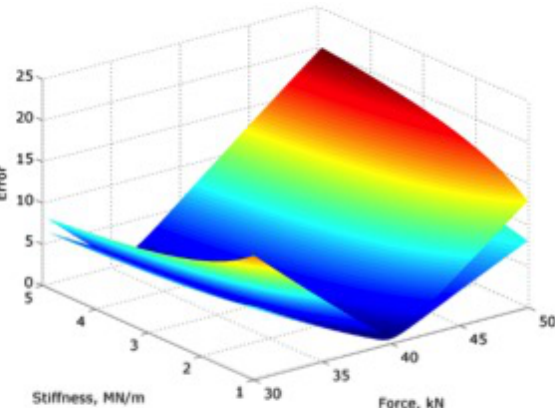
Figure 5. Influence of the elastic bed stiffness on the minimal